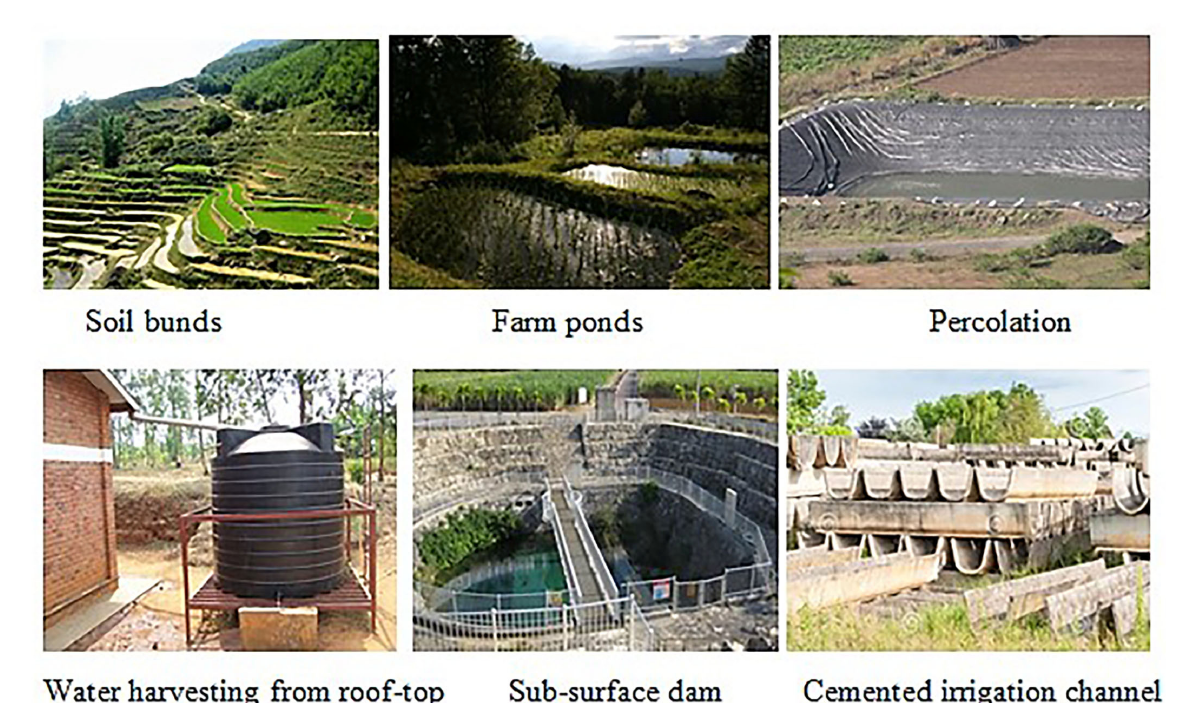
FIGURE10 Water catchment infrastructure for drought-prone areas. Pictures collected from google